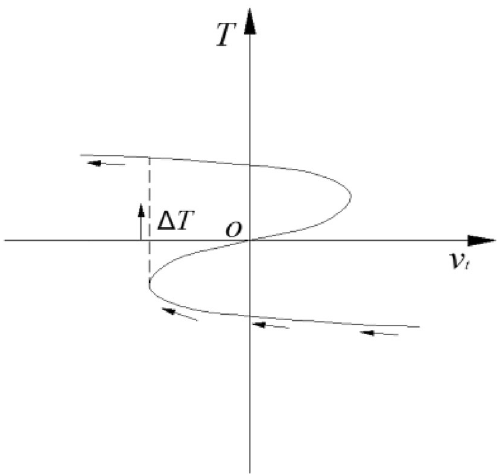
Figure 11. Jump form of state variable